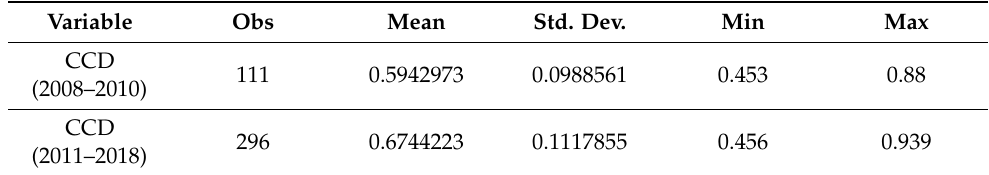
Table 2. Descriptive CCD statistics